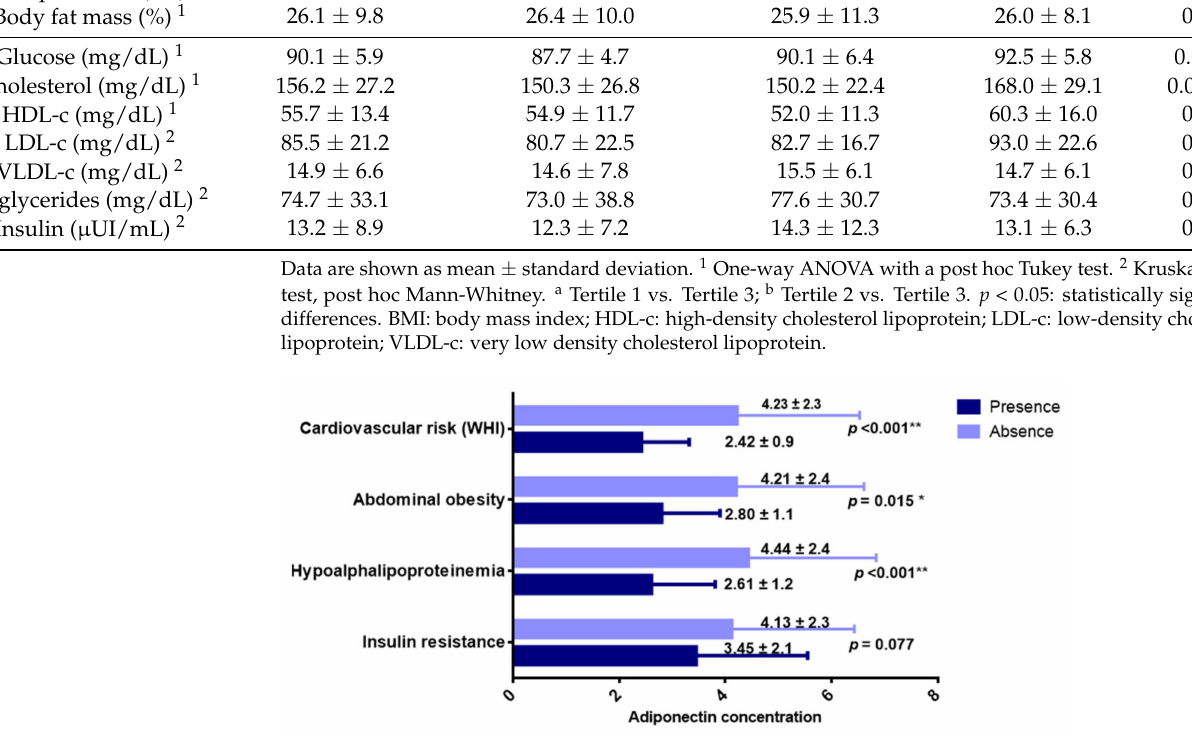
Figure 2. Adiponectin concentration ( µ g/mL) in the presence of metabolic risks. Data are shown as mean ± standard deviation. U Mann–Whitney. * p < 0.05. ** p <